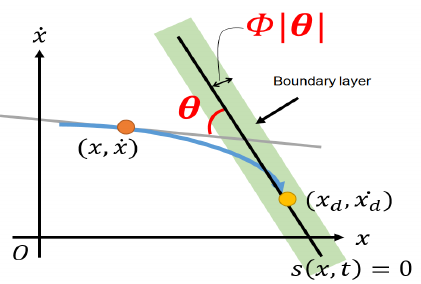
Figure 5. Schematic views of phase trajectory of (cid:21) (blue arrow) and its tangent line(gray line).